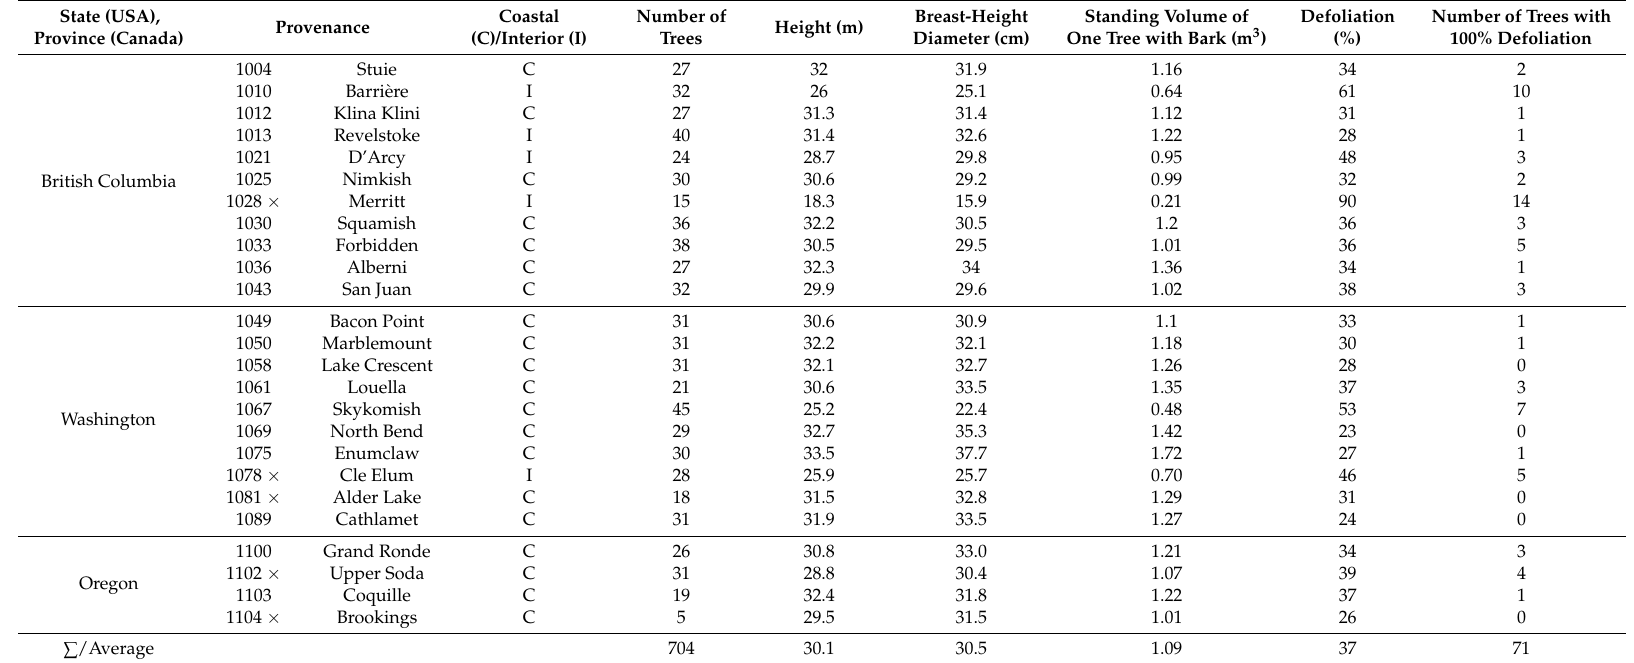
Table 3. Mean quantitative characteristics